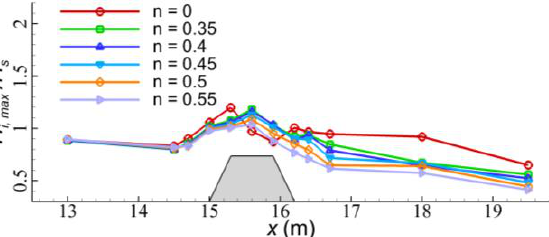
Figure 21. Spatial distribution of the maximum local wave heights over the submerged breakwater with different porosities.